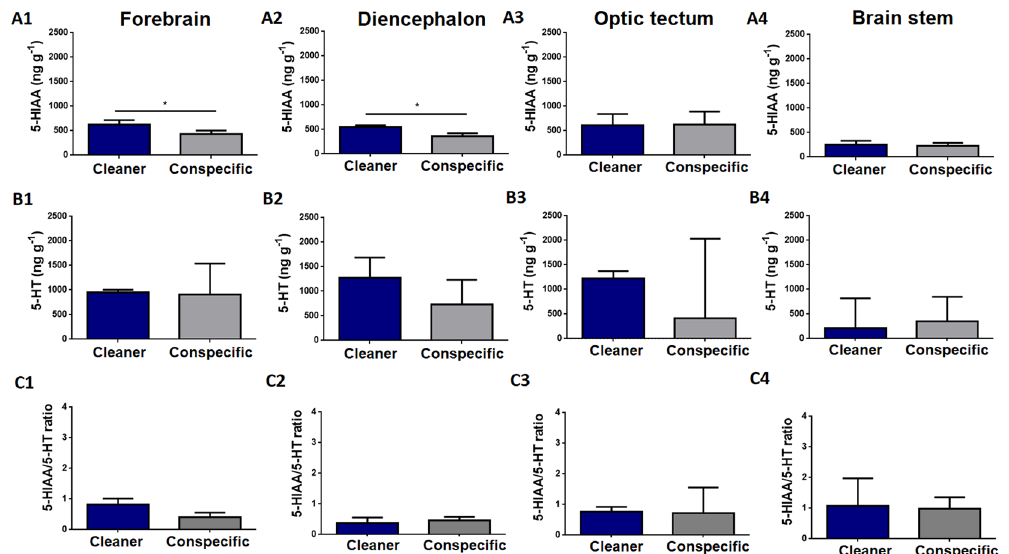
Figure 1. Serotonergic levels across clients’ brain areas exposed to a cleaner ( Labroides dimidiatus ) or a conspecific ( Naso elegans ). 5-hydroxyindoleacetic acid (5-HIAA) in the (A1) forebrain (FB) area (U = 8; p = 0.04; η 2 = 0.32), (A2) diencephalon (DL) area (U = 6; p = 0.02; η 2 = 0.27), (A3) optic tectum (OT) area (U = 23; p = 0.87; η 2 = 0.01), (A4) brain stem (BS) area (U = 23; p = 0.87; η 2 < 0.01). Serotonin (5-HT) in the (B1) FB area (U = 18; p = 0.45; η 2 = 0.1), (B2) DL area (U = 16; p = 0.3; η 2 = 0.12), (B3) OT area (U = 20; p = 0.6; η 2 = 0.03), (B4) BS area (U = 16; p = 0.52; η 2 = 0.01). 5-HIAA/5-HT ratio in the (C1) FB area (U = 11; p = 0.09; η 2 = 0.29), (C2) DL area (U = 20; p = 0.6; η 2 < 0.01), (C3) OT area (U = 23; p = 0.87; η 2 = 0.01), (C4) BS area (U = 15; p = 0.43; η 2 = 0.08). Medians and interquartile ranges are shown. Significant values from Mann-Whitney U tests are shown above bars: * <